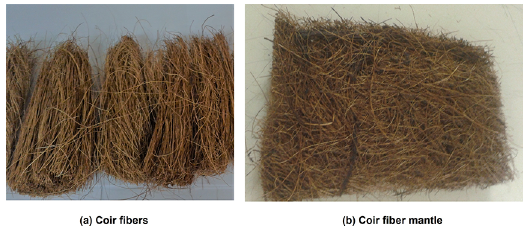
Figure 1. Coir fibers extracted from the mesocarp in the husk of a green coconut fruit (a) and coir fiber mantle (b).